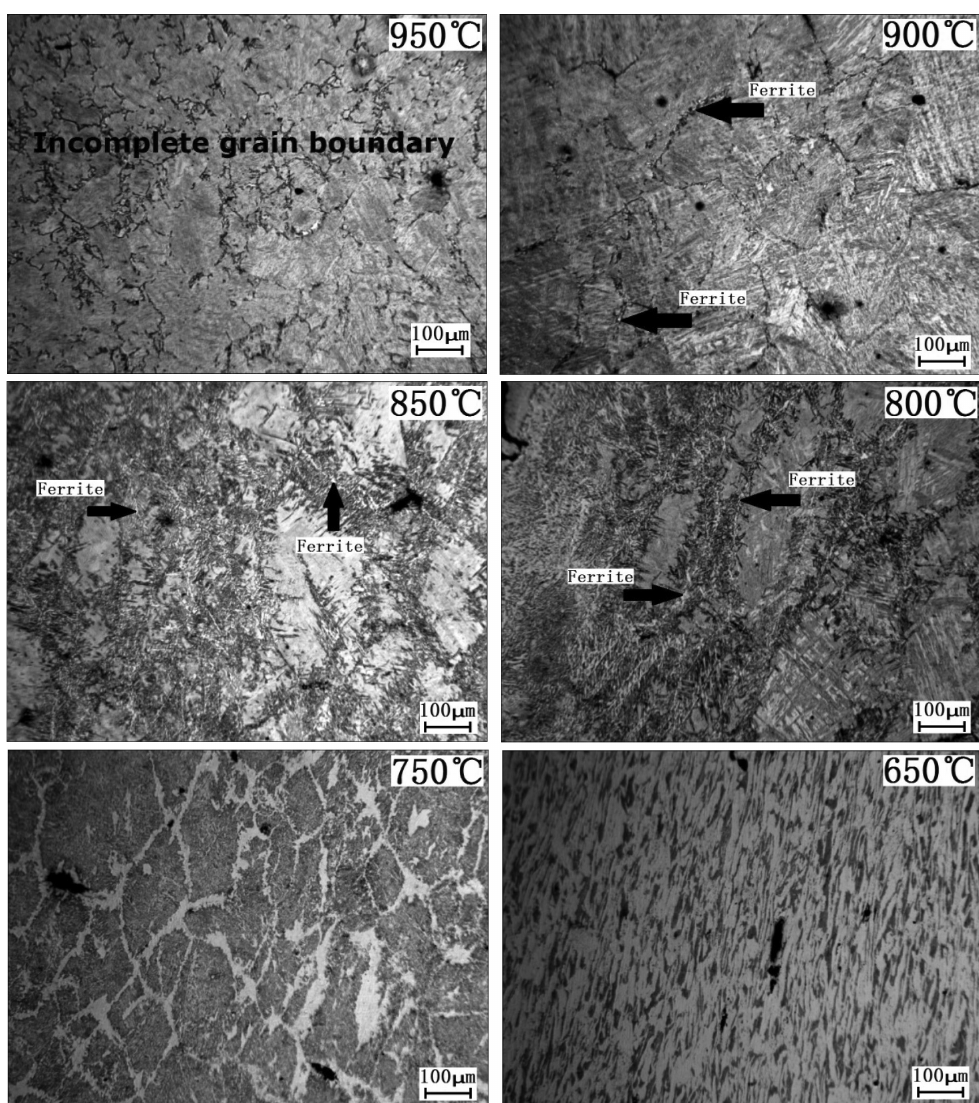
Fig. 5: Microstructure pictures at different temperatures in Ti-bearing